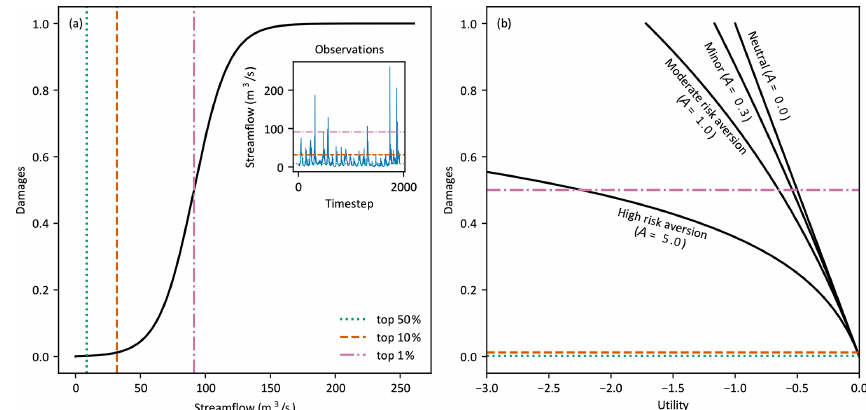
Figure 3. (a) Example damage function used in the illustrative case study based on a logistic curve with an inflection point at the top 1% of observed flow and (b) corresponding CARA utility function with four levels of risk aversion (limited to − 3 ≤ utility ≤ 0 and aligned at zero utility for visual